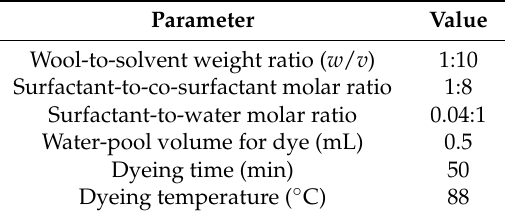
Table 1. Dyeing parameters for octane and nonane.